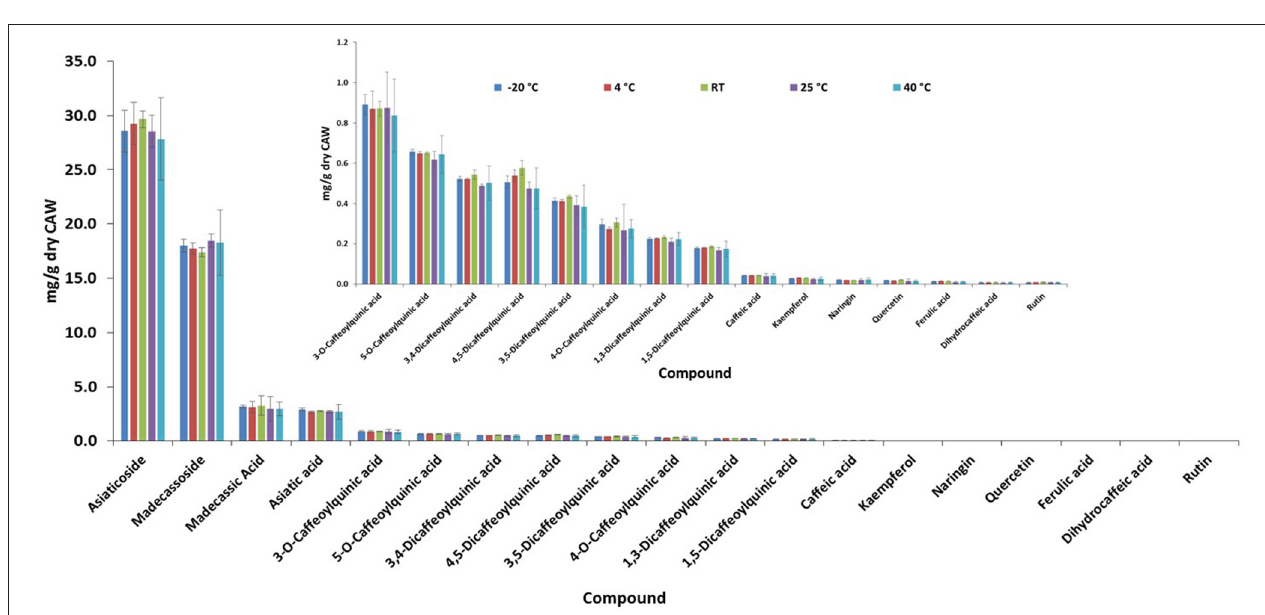
FIGURE 4 | A 32-day stability test of CAP 2g and 4g showing unchanged levels of triterpene and caffeoylquinic acid components at all temperatures as determined by LC-HRMS. Storage conditions: 25 ± 2 ◦ C/60% ± 5% relative humidity, accelerated 40 ± 2 ◦ C/75% ± 5% relative humidity, fridge (4 ◦ C), ambient temperature (RT), and freezer ( − 20 ◦ C) ( n = 3–6 per